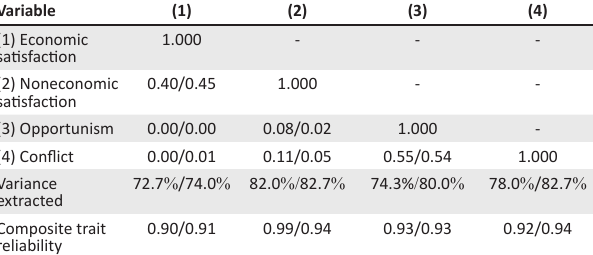
TABLE 6: Squared interconstruct correlations, variance extracted and composite trait reliability of constructs in purchase and sales business relationships. Variable